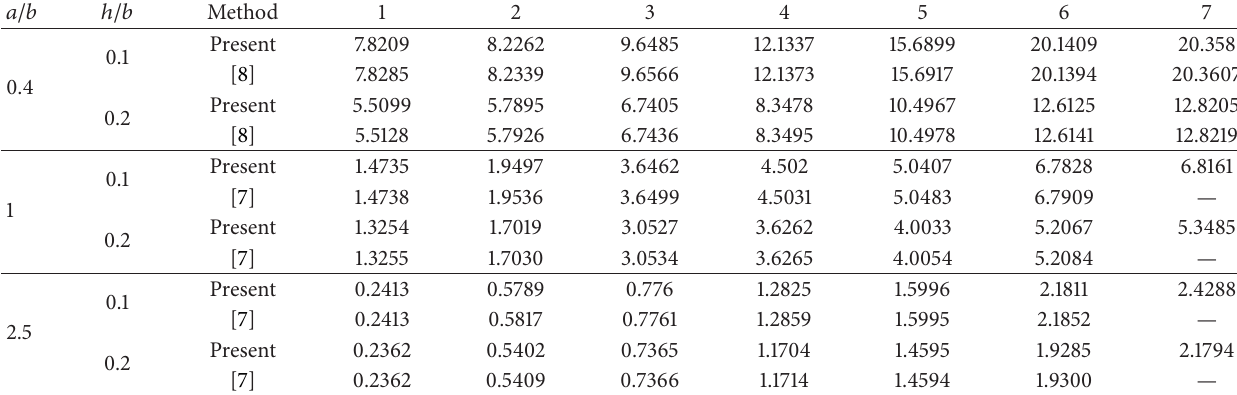
Table 4: The first seven frequency parameters Ω = ( 𝜔𝑏 2 / 𝜋 2 )( 𝜌ℎ/𝐷 ) 1/2 for C-F-S-F Mindlin rectangular plates.